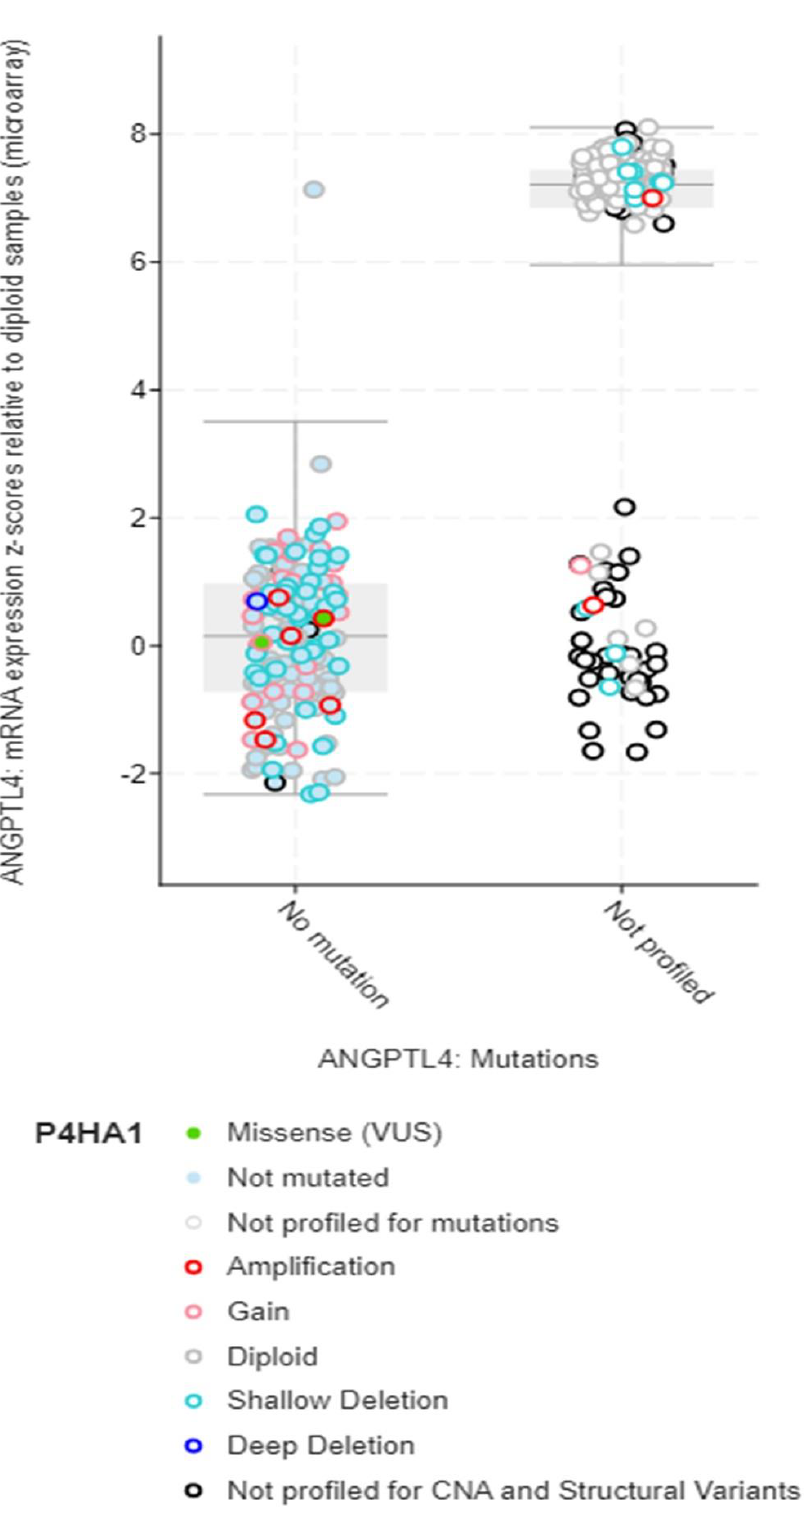
Figure 6. mRNA expression vs. P4HA1.